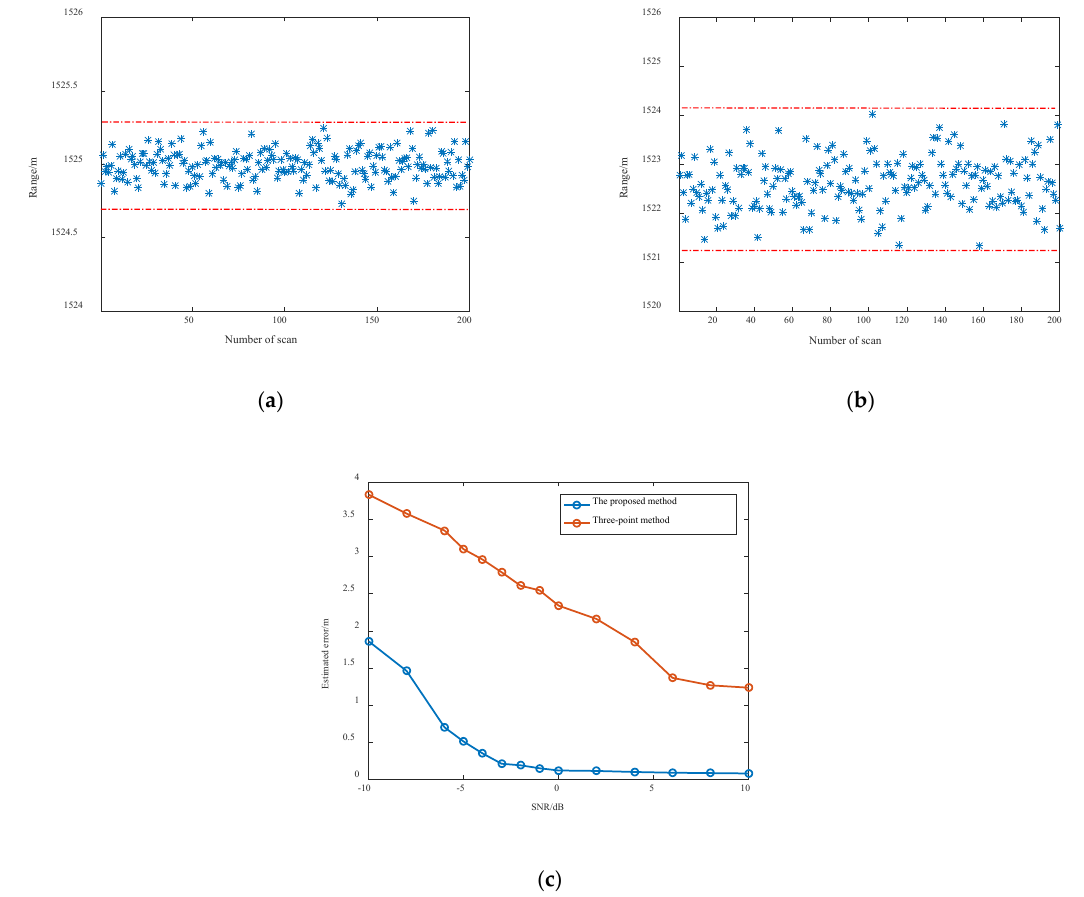
Figure 13. Measurement ranges of the proposed method ( a ) and the three-point method ( b ) in 200 − time experiment with SNR of 0 dB; range performance of the two methods with different SNRs ( c ).